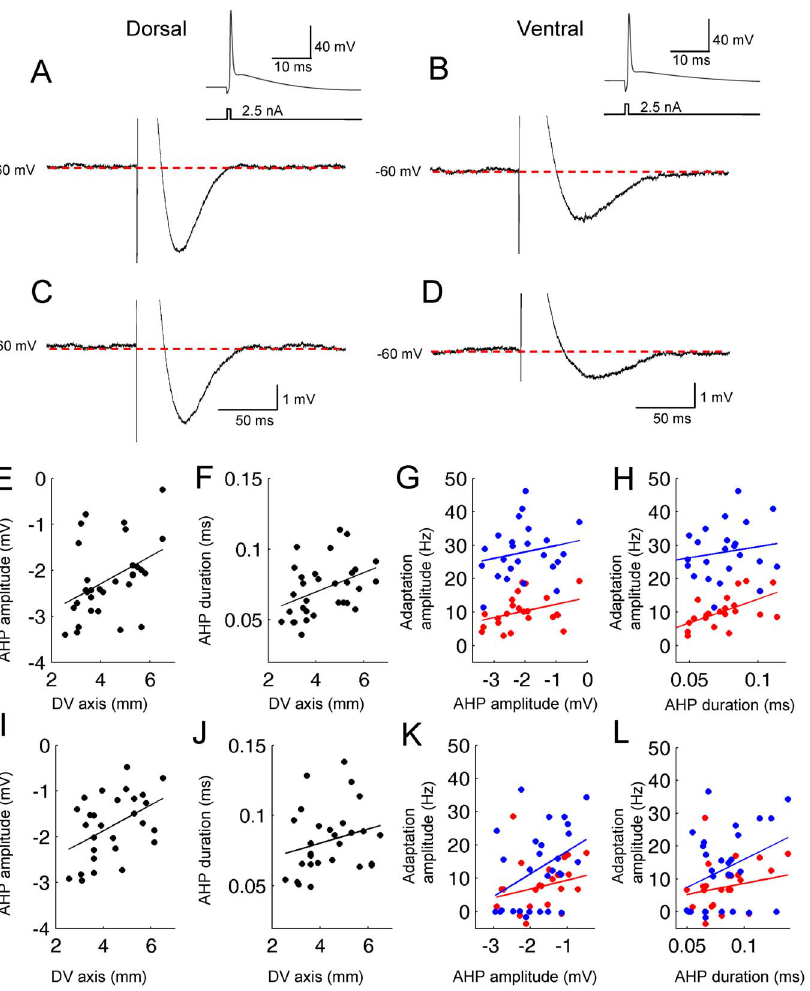
Figure 4. Spike AHP duration and amplitude systematically change along the DV axis. (A and B) Examples of AHP in the normal ACSF in a dorsal (A) and a ventral cell (B). The AHP was induced by one action potential elicited by a 1 ms current injection from the baseline membrane potential of 2 60 mV. Inset shows this action potential. (C and D) Examples of AHP in carbachol (10 m M) in a dorsal (C) and a ventral cell (D). (E) Amplitudes of AHP in normal ACSF plotted on the DV axis. (F) Duration of AHP in normal ACSF plotted on the DV axis. (G) Correlation between the amplitude of AHP and the adaptation amplitude in normal ACSF. Adaptation amplitudes of exponential fit with and without the first two spikes are plotted with blue and red dots, respectively. The color code is the same for all other plots. (H) Correlation between the duration of AHP and the adaptation amplitude in normal ACSF. (I) Amplitudes of AHP in carbachol plotted on the DV axis. (J) Duration of AHP in carbachol plotted on the DV axis. (K) Correlation between the amplitude of AHP and the adaptation amplitude in carbachol. (L) Correlation between the duration of AHP and the adaptation amplitude in carbachol.